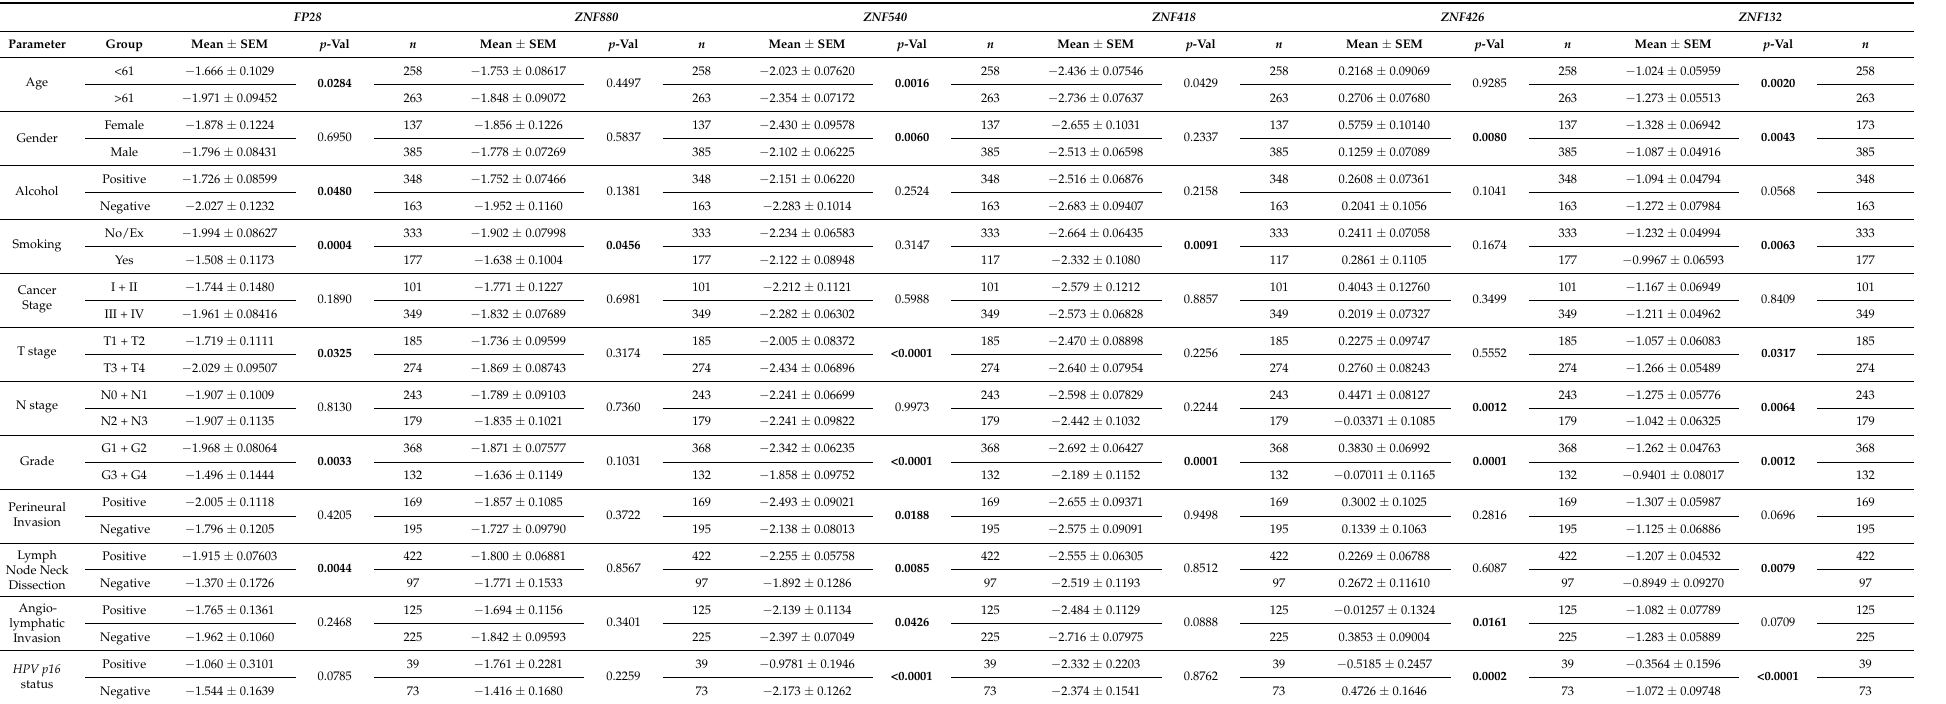
Table 1. Expression levels of ZFP28 , ZNF132 , ZNF418 , ZNF426 , ZNF540 , and ZNF880 depending on clinical-pathological parameters. t -test or Mann–Whitney U test was used to assess the statistical significance; n —number of cases. The differences with p < 0.05 were considered as significant and marked in bold in the specified